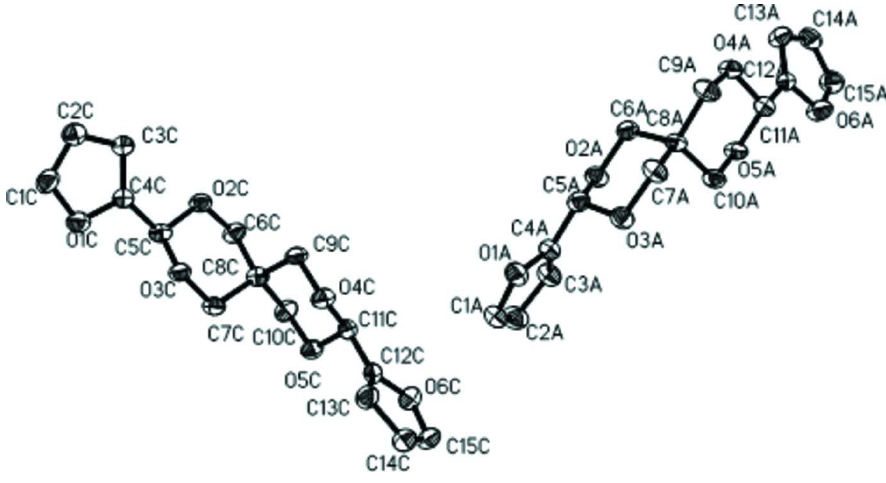
Figure 1 The molecular structure of (I) with the atom-labeling scheme. Displacement ellipsoids are drawn at the 30% probability